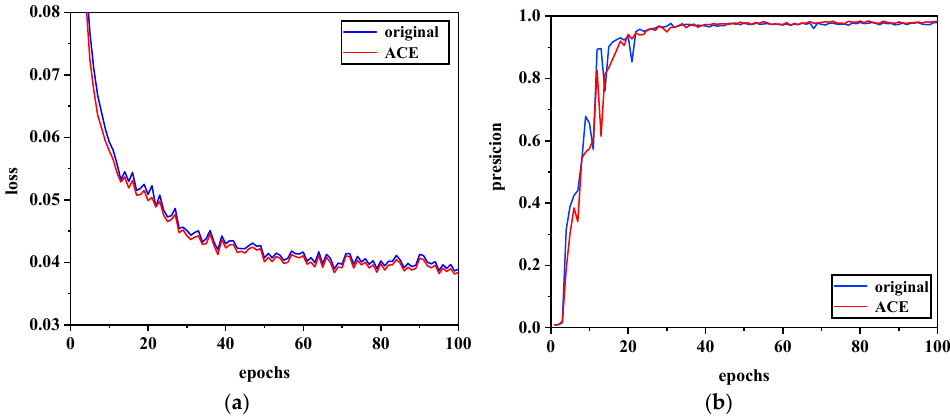
Figure 10. The curve of the training process of the first-level network on the original data and the data processed by the ACE method. ( a ) Loss curve of training; ( b ) precision curve of training.